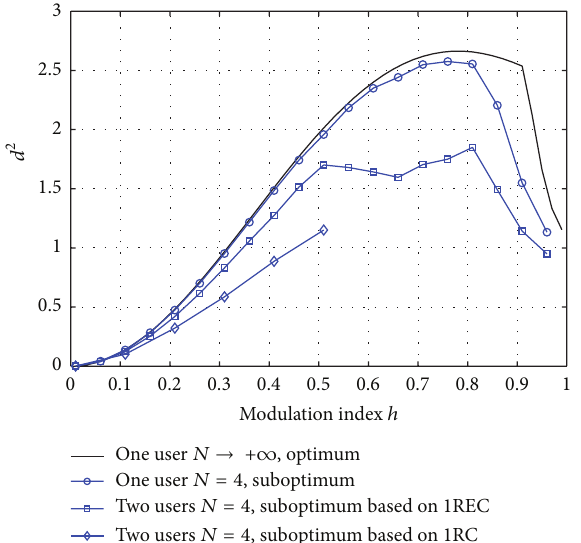
Figure 4: The minimum achievable distance 𝑑 2 versus the modula- tion index ℎ . Δ𝑓 = 0 and Δ𝜙 is